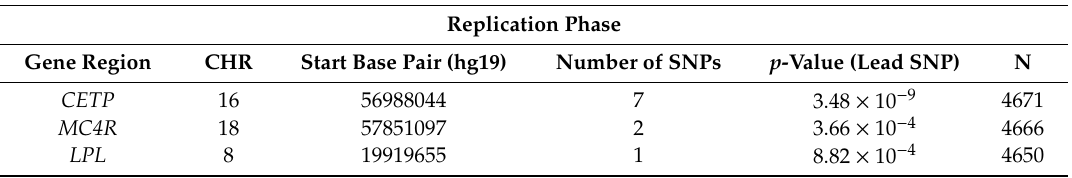
Table 1. Association status of known metabolic traits associated gene regions with MetS in replication phase in Indians ( p < 1 × 10 − 3